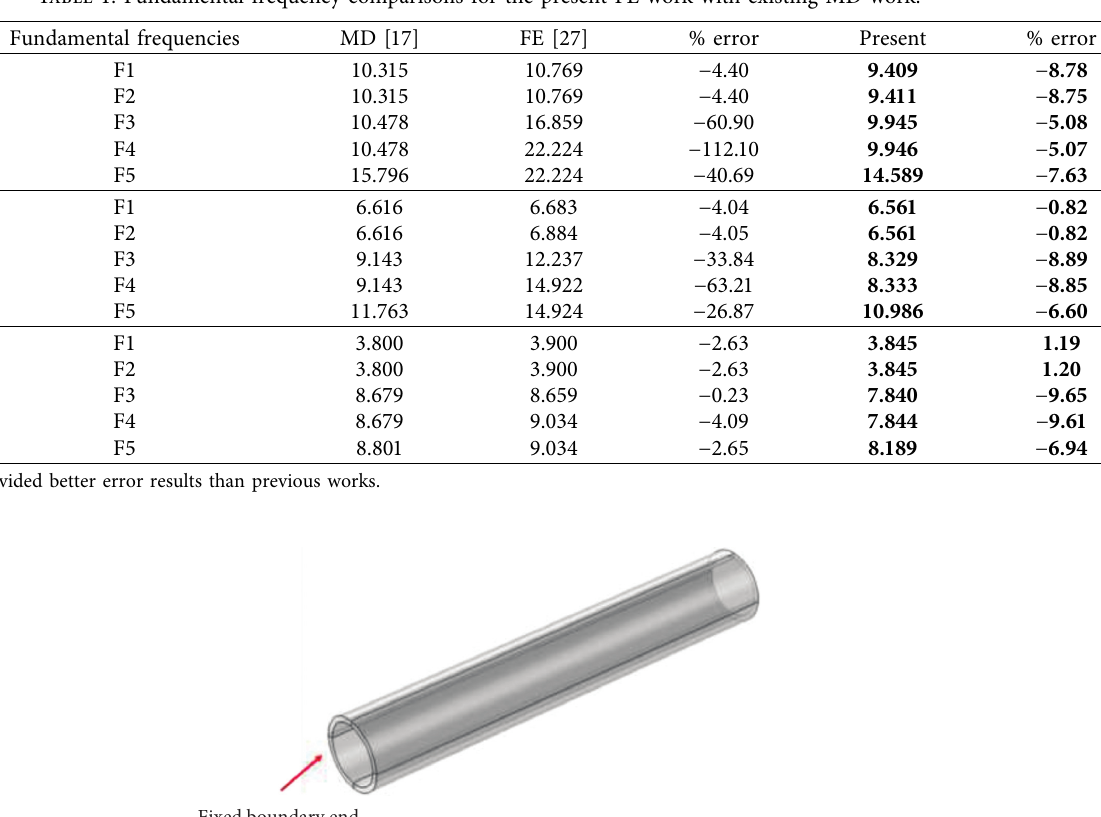
Figure 6: Fixed-free boundary fundamental frequency analysis (one end is fixed and another one end is